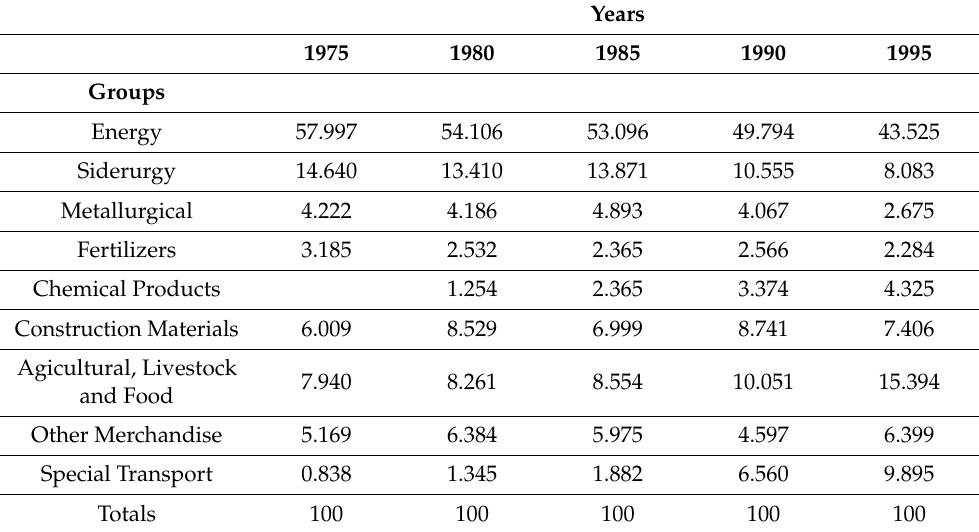
Table 3. Percentage of goods by group and